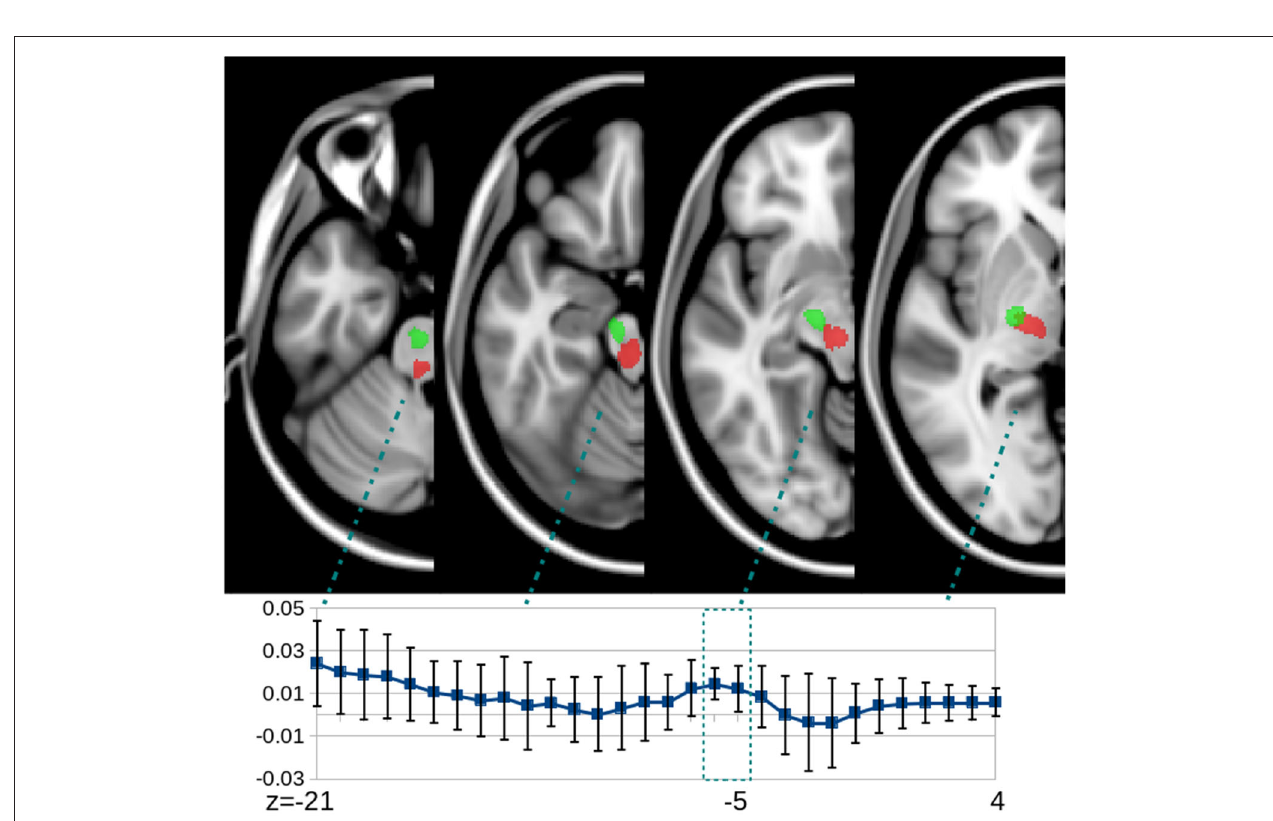
FIGURE 3 | Graphs showing fractional anisotropy (FA) changes ( ± standard deviation) in the CST and aMF ROIs, in the treated and untreated group, on both hemispheres . Only the FA extracted from the aMF ROI on the lesion side of the treated group